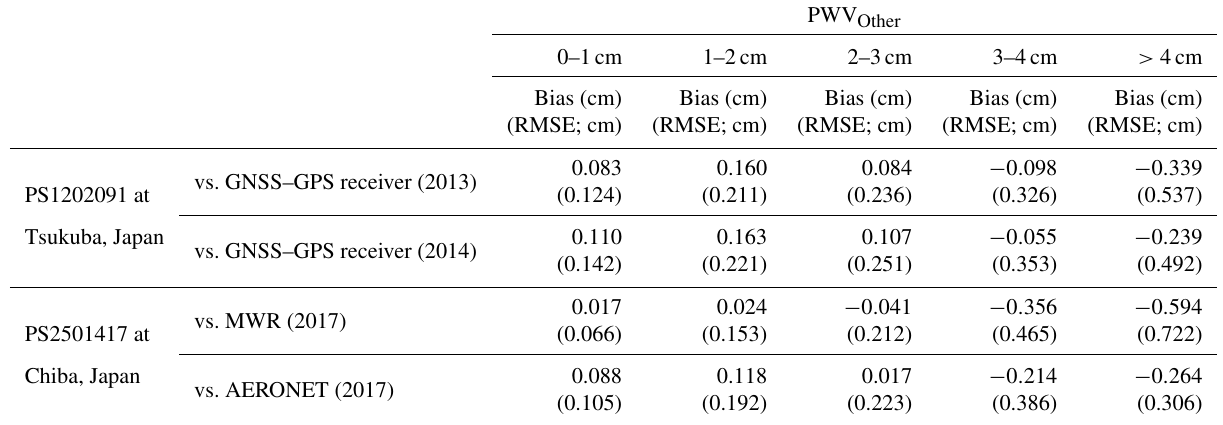
Table 6. Difference in PWV between DSRAD with the annual mean calibration constants and other instruments.